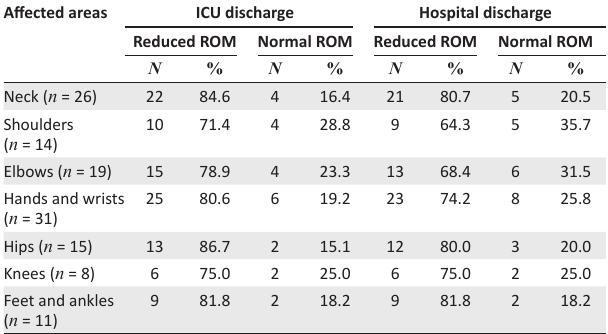
TABLE 4: Joint range of motion changes recorded at intensive care unit discharge and prior to hospital discharge for affected areas ( n = 73). Affected areas